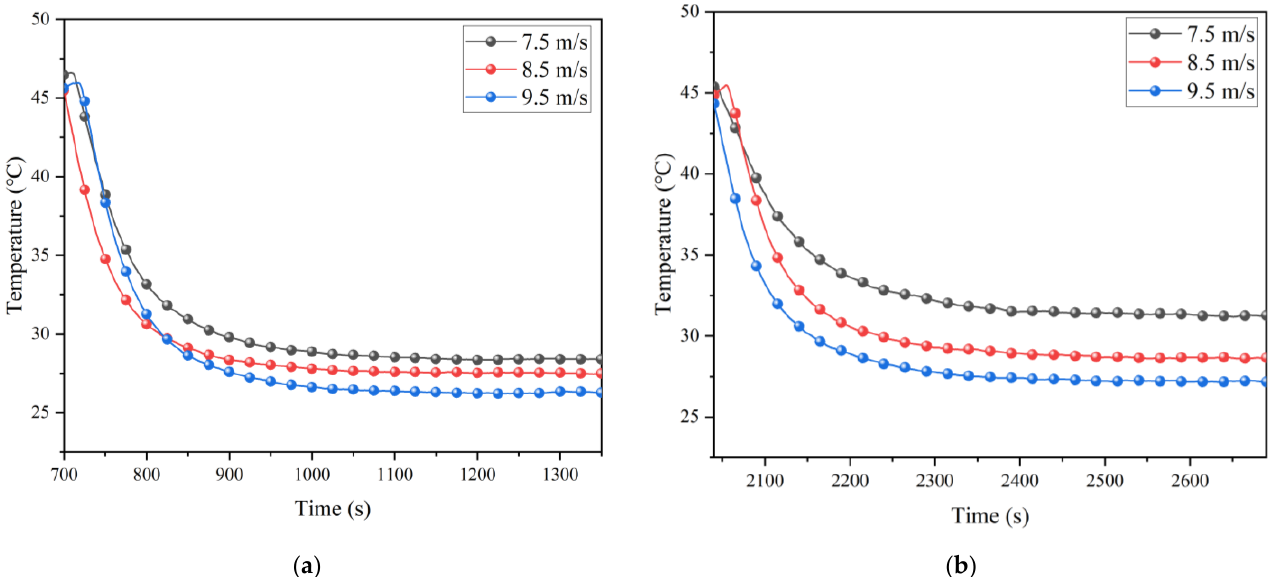
Figure 9. Average cool-down at different air velocities with and without insulation: ( a ) With insulation; ( b ) Without insulation.